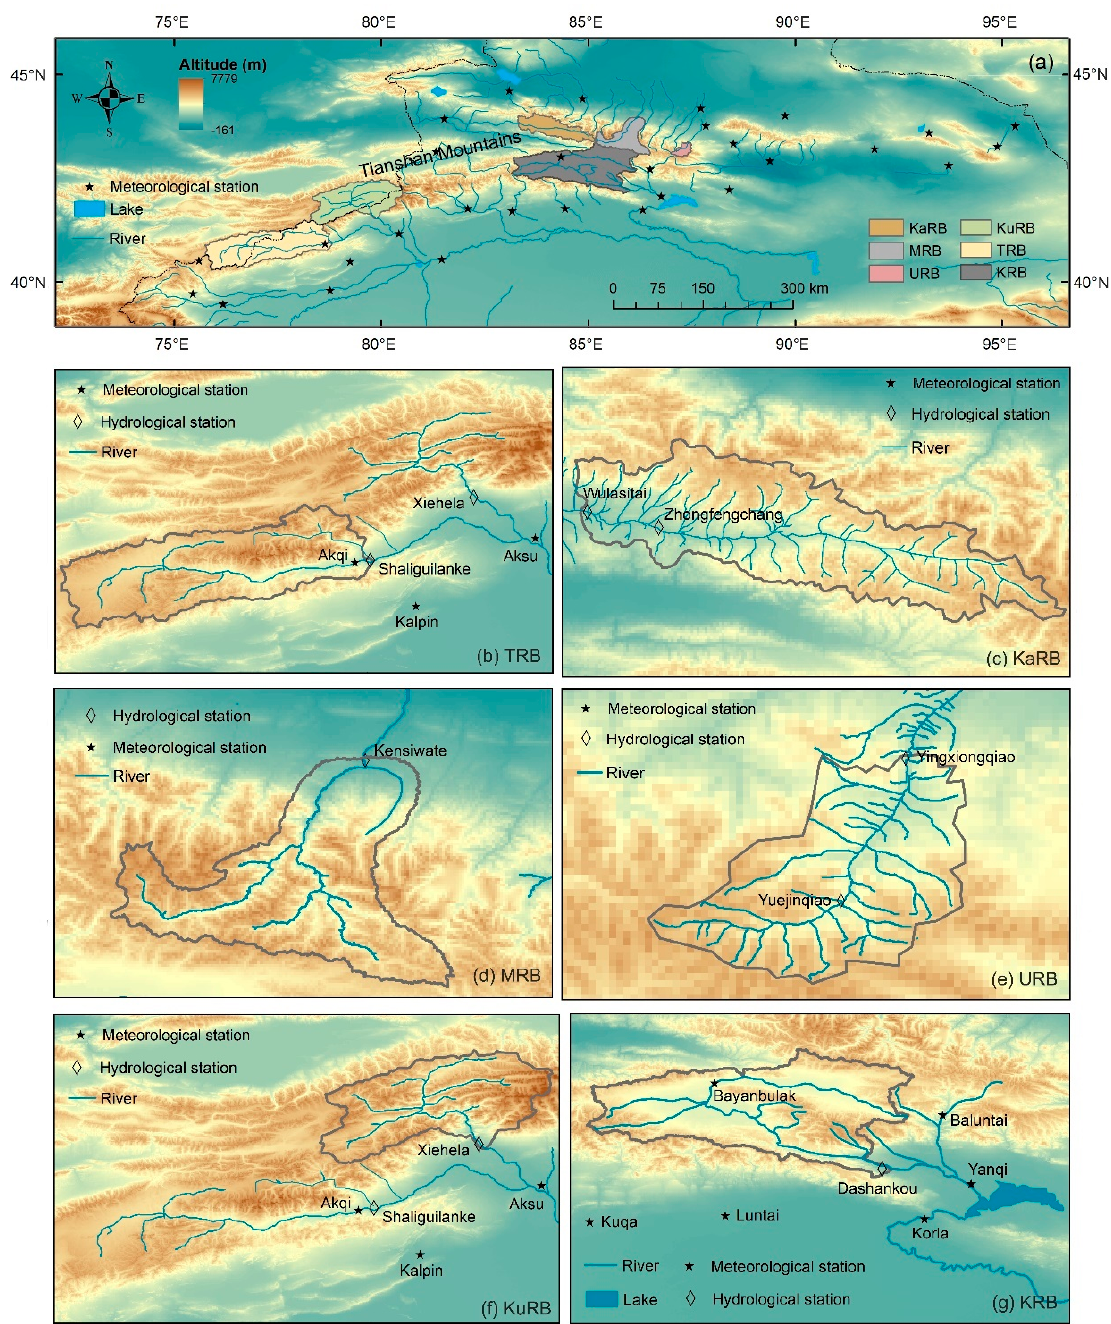
Figure 1. The study area. ( a ) Tianshan Mountains, ( b ) Toxkan River basin, ( c ) Kashgar River basin, ( d ) Manas River basin, ( e ) Urumqi River basin, ( f ) Kumaric River basin, and ( g ) Kaidu River basin. The reanalysis products include ERAP, ERAT, and the Digital Elevation Model